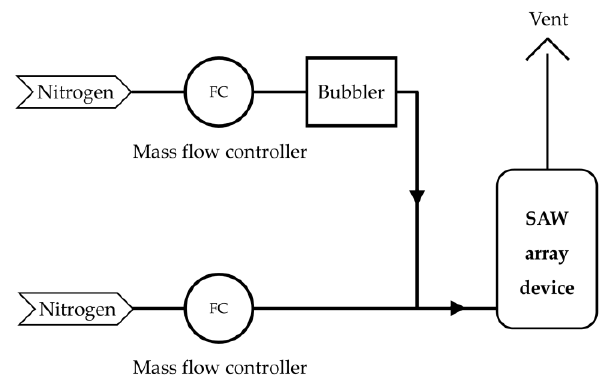
Figure 5. Schematic diagram of the in house experimental setup for testing the SAW array device with a simulant, DMMP (Inha University, South Korea).